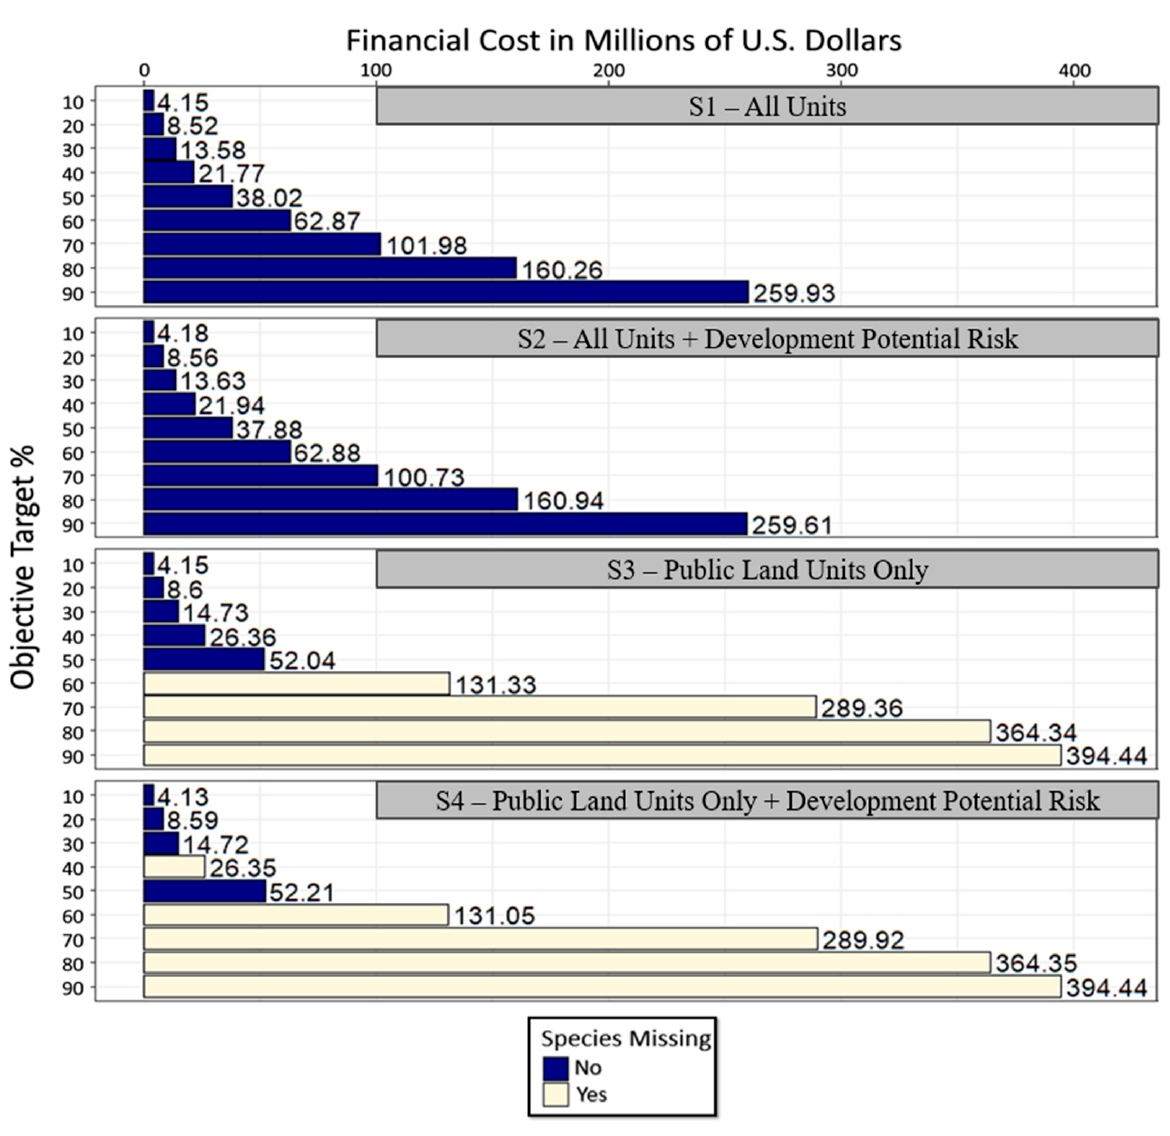
Figure 4. Marxan analysis results for financial cost distributions across conservation target percent- ages. Blue color depicts scenario runs that have reach conservation targets for all species; Tan color depicts scenario runs in which at least 1 species conservation target percentage is not obtainable due to risk, planning unit availability, and financial cost.